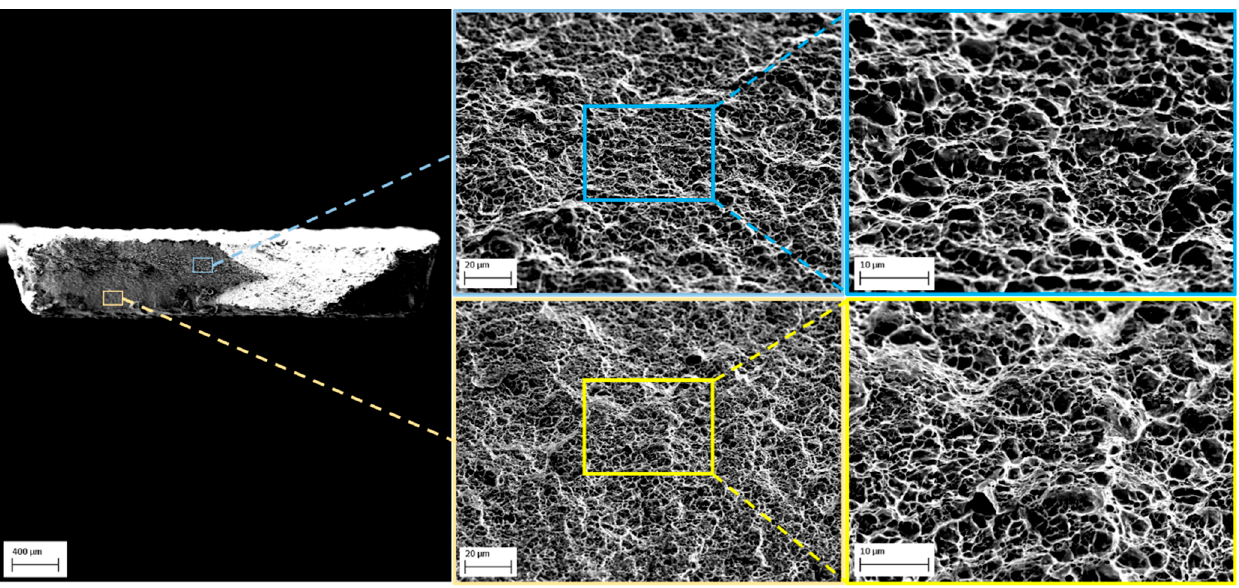
Figure 7. SEM micrographs of fracture surface of DP1000 AHSS Corroding specimen with NaCl deposits exposed in humid air at 85% RH for 27 days.